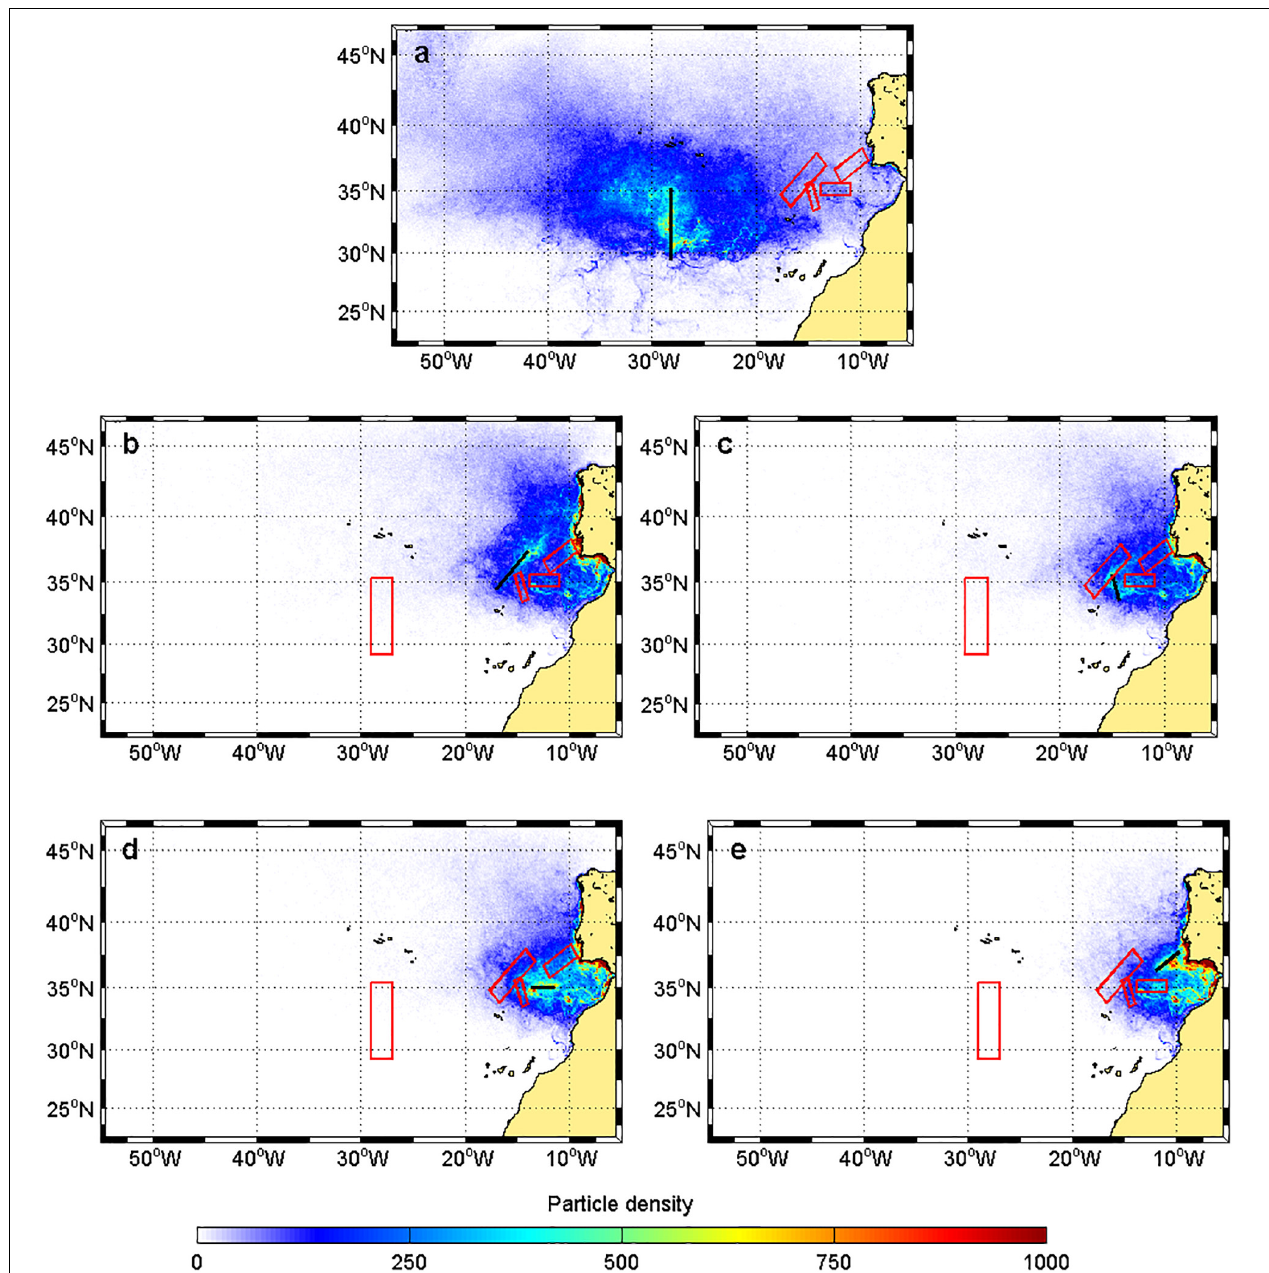
FIGURE 3 | Particle density distribution for the reverse particle tracking study at 5 m depth for particles released at the different seamounts: (a) Great Meteor, (b) Lion-Josephine, (c) Unicorn-Seine, (d) Ampere-Coral, and (e) Gorringe Bank. The black bar corresponds to the final destination of the particles. The red boxes represent the nearby seamounts of interest (as identified in Figure 1b